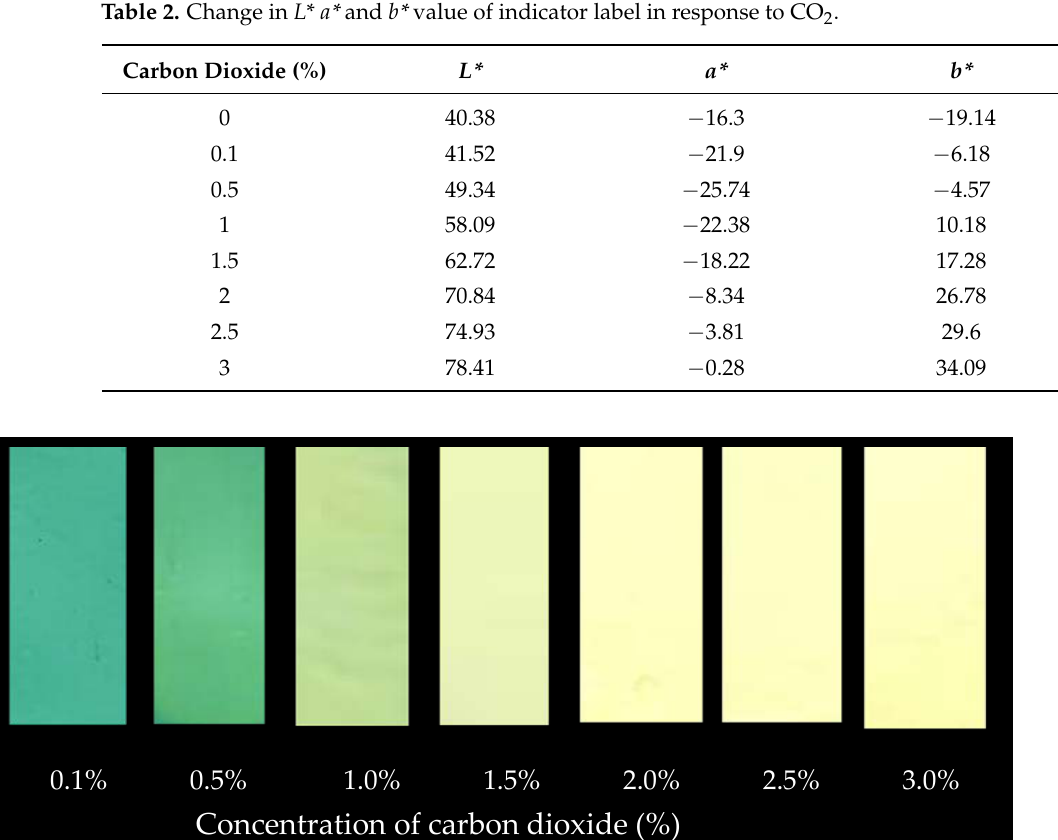
Table 2. Change in L * a *and b *value of indicator label in response to CO 2 .